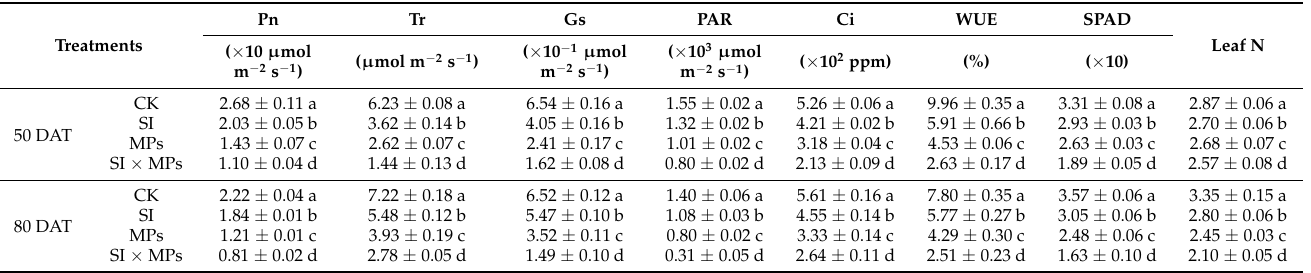
Table 3. Mean rice photosynthetic parameters at the 50th and 80th days after transplanting, presented as the mean ± standard error ( n =